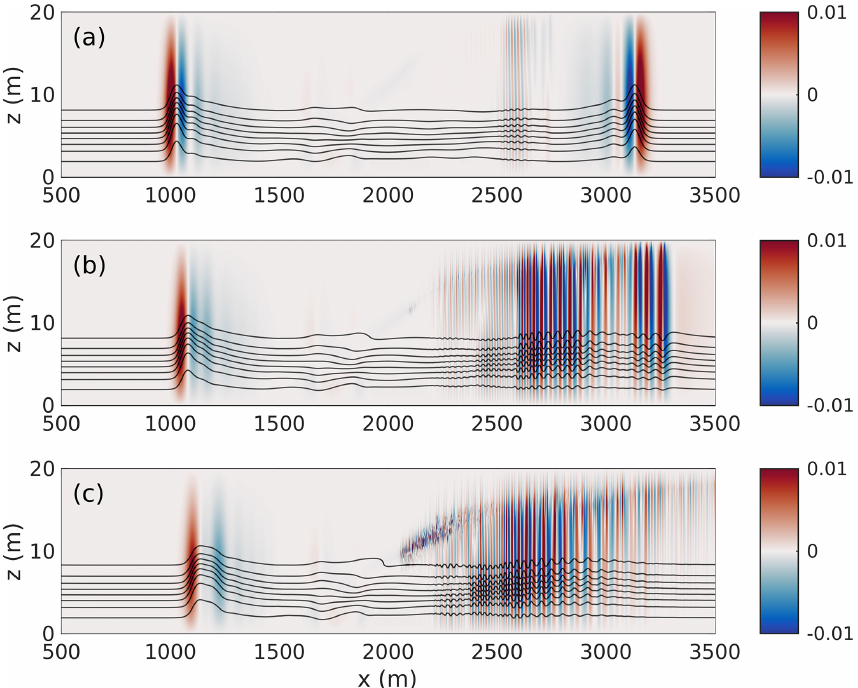
Figure 12. The vertical component of velocity (shaded) saturated at ± 0 . 01ms − 1 with eight isolines of density superimposed at t = 5400s.